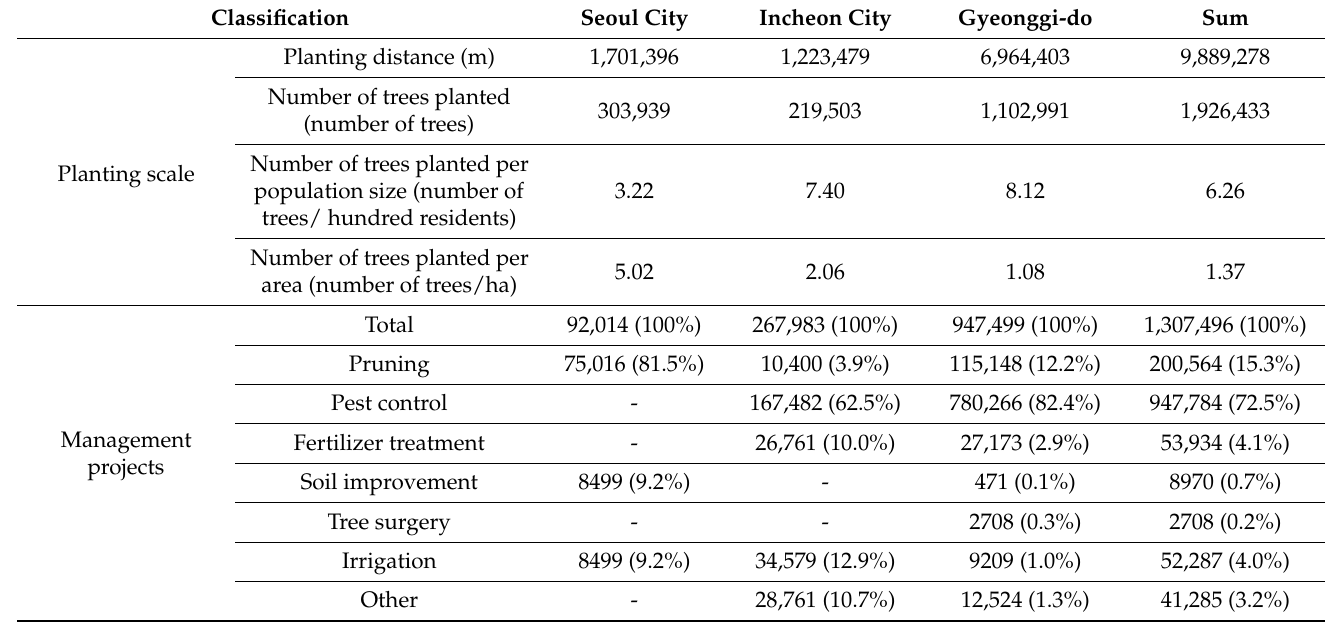
Table 2. Planting and management status of street trees in the study area.